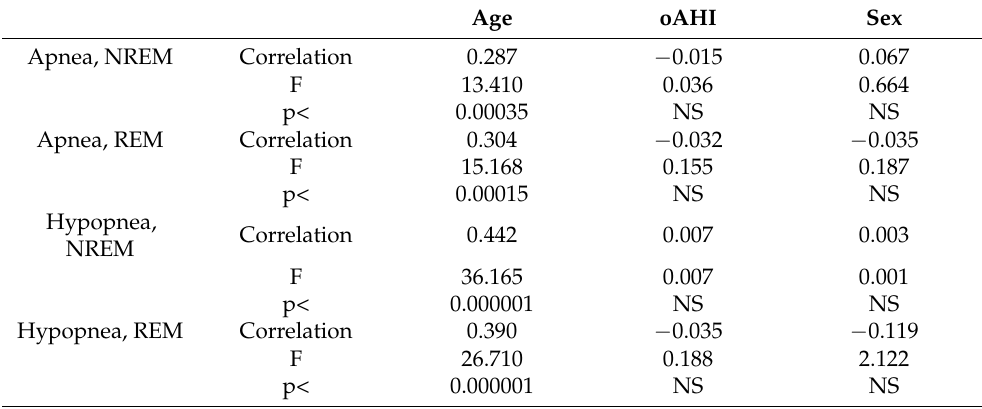
Table 1. Analysis of the simultaneous effects of age, sex, and obstructive apnea/hypopnea index on the duration of apnea and hypopnea during NREM and REM sleep, separately. The partial correlation coefficients are reported for each predictor, as well as their statistical